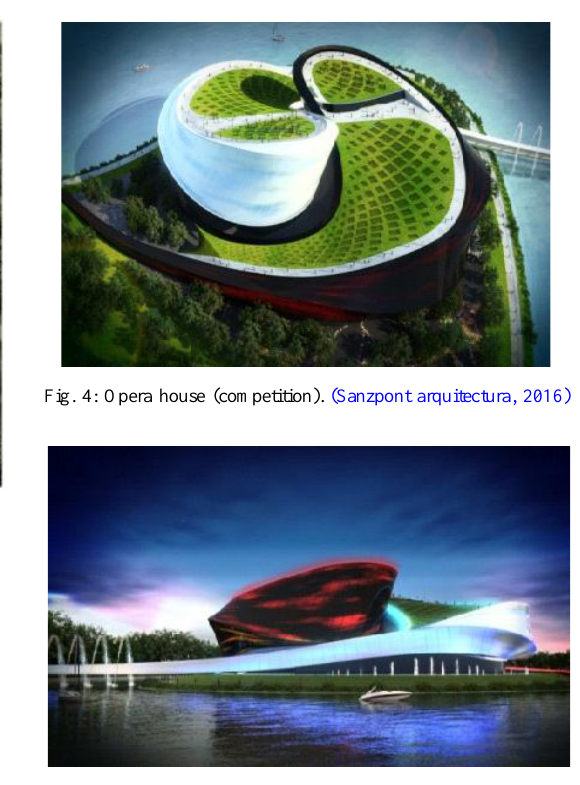
Fig. 5: Opera house (competition). (Sanzpont arquitectura, 2016)